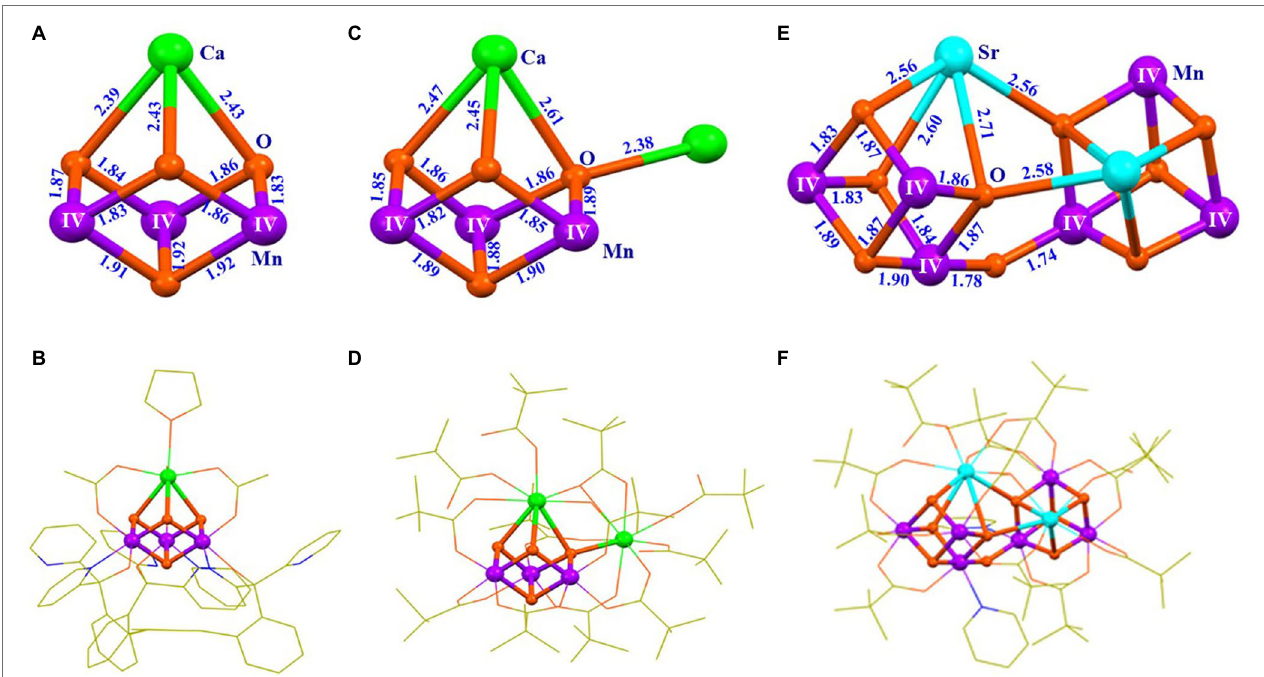
FIGURE 4 | Structures of three artificial complexes containing Mn 3 XO 4 cubane (X = Ca/Sr). (A) Core of the Mn 3 CaO 4 -complex ( 1 ); (B) Structure of the Mn 3 CaO 4 - complex ( 1 ) (Kanady et al., 2011); (C) Core structure of the Mn 3 Ca 2 O 4 -complex ( 2 ); (D) Structure of the Mn 3 Ca 2 O 4 -complex ( 2 ) (Mukherjee et al., 2012); (E) Core of the (Mn 3 SrO 4 ) 2 O-complex ( 3 ); (F) Structure of the (Mn 3 SrO 4 ) 2 O-complex ( 3 ) (Chen et al., 2014). Distances are given in Å units; Mn, Ca, Sr., O, N, and C are shown in purple, green, cyan, orange, blue, and yellow, respectively. For clarity, all hydrogen atoms are not